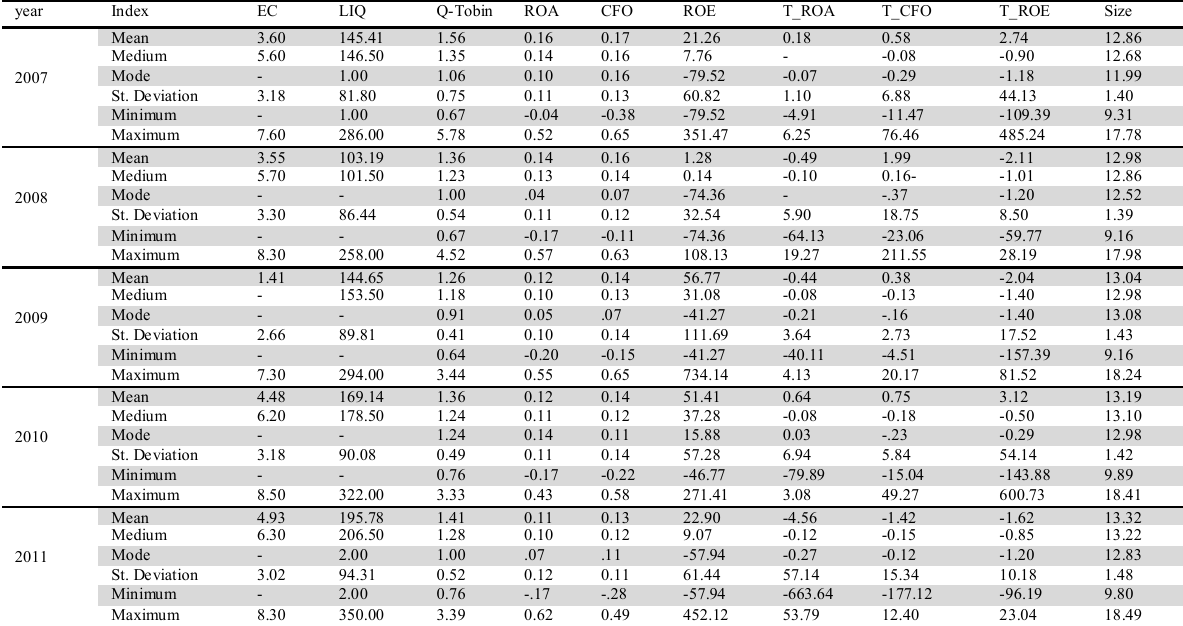
The summary of descriptive